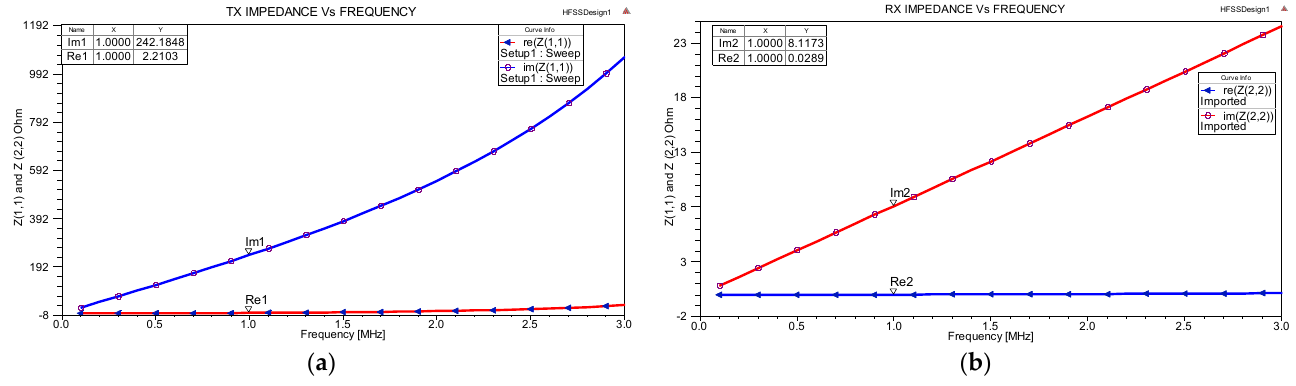
Figure 14. The Im and Re of STLAC and MTSCC lumped circuit and performance parameters of lateral misalignment at a 2 cm distance for ( a ) transmitter coil (T X ), and ( b ) receiver coil (R X ).